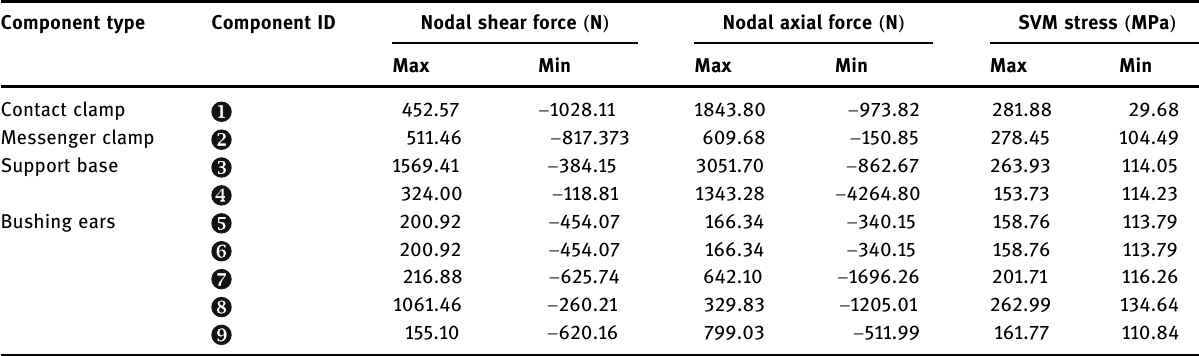
Table 9: Peak values of nodal forces and structural stress at connection